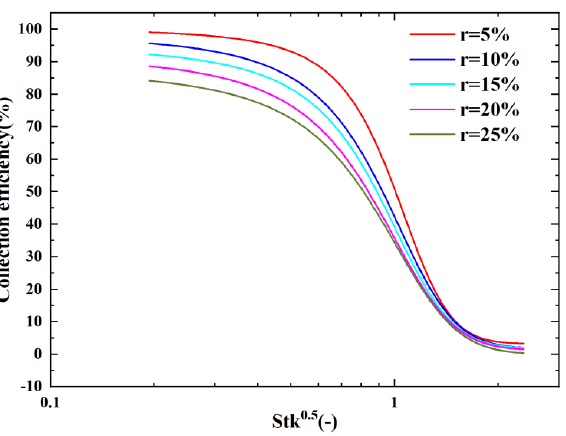
Figure 9. The effect of r on the CE curves using Stk 0.5 as the absciss.